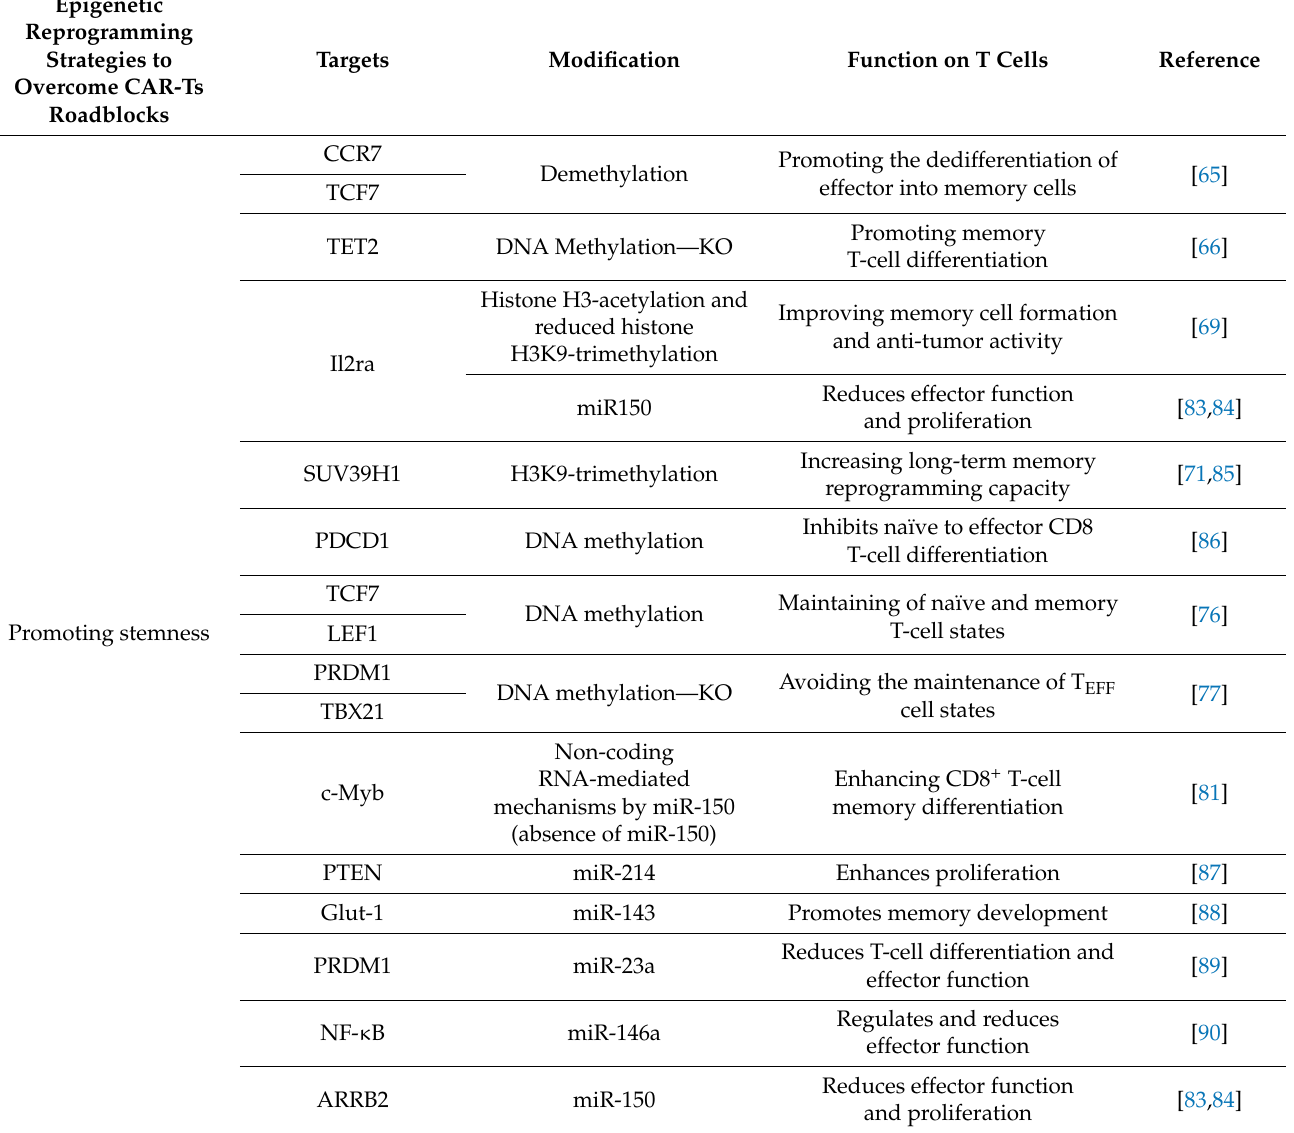
Table 1. Major epigenetic regulators associated with T-cell differentiation, exhaustion, and